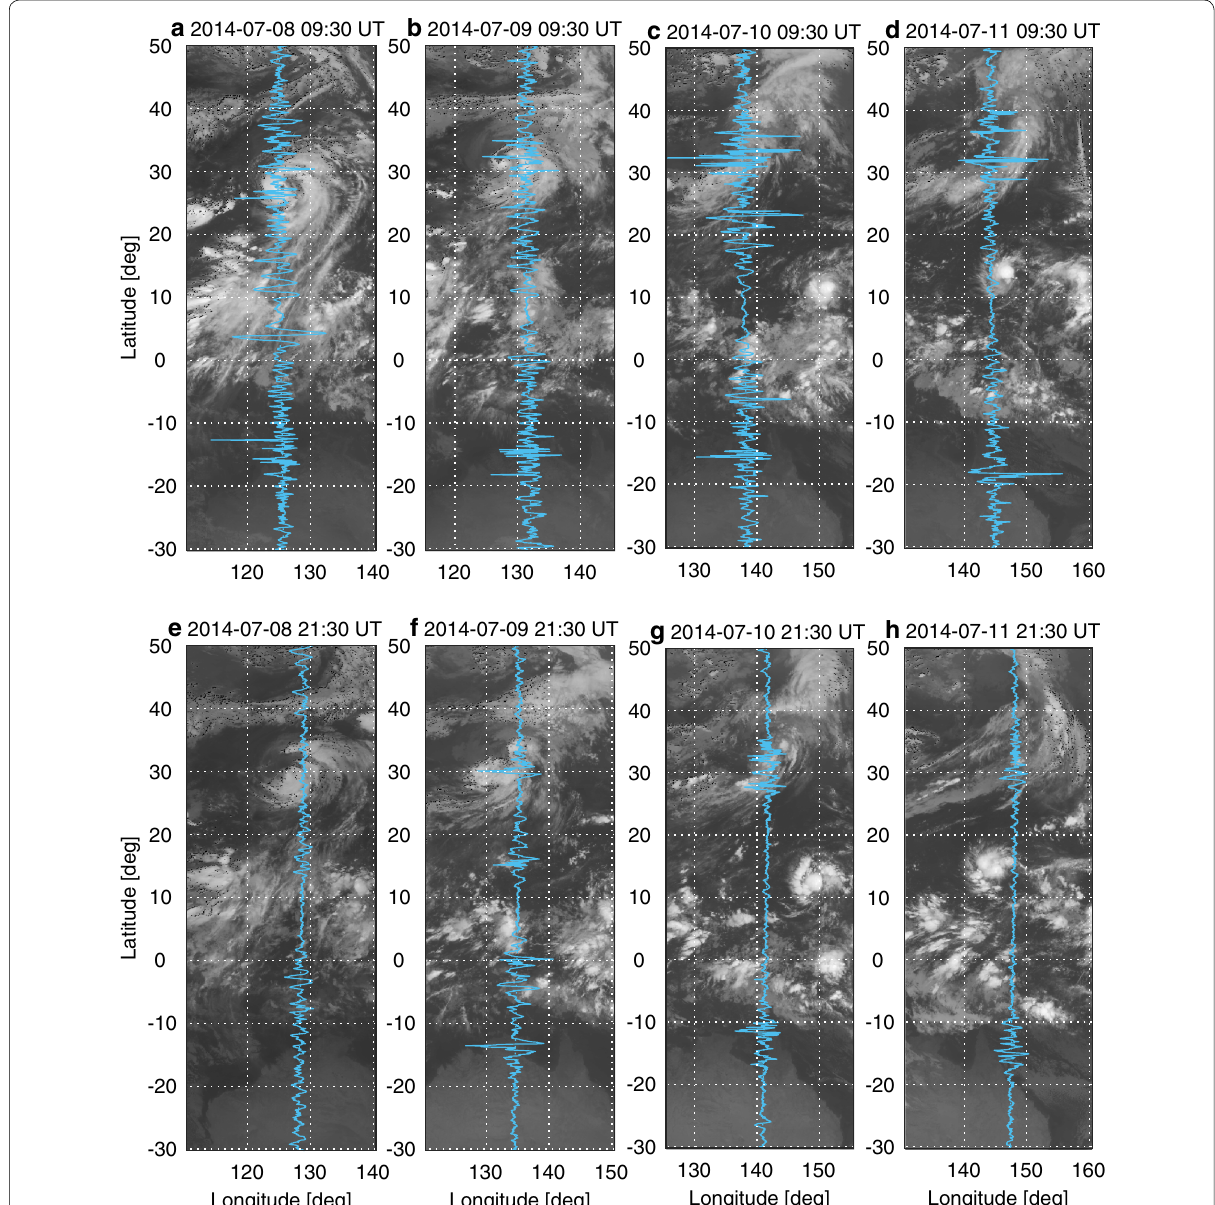
Fig. 8 IR cloud images plotted from IR brightness temperature data on each day. MRs are overlaid ( light blue solid lines ). Upper and lower panels are 18 and 6 LTs,